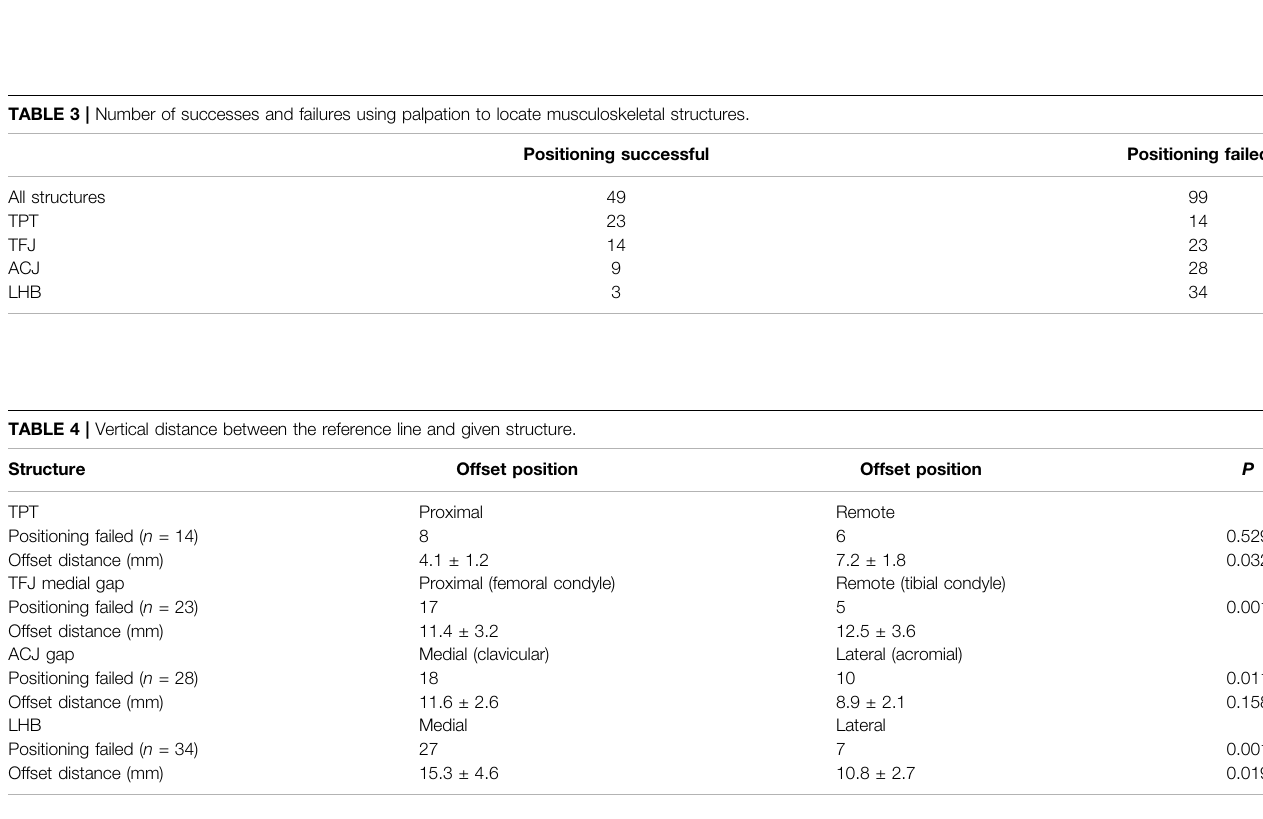
TABLE 3 | Number of successes and failures using palpation to locate musculoskeletal structures. All structures